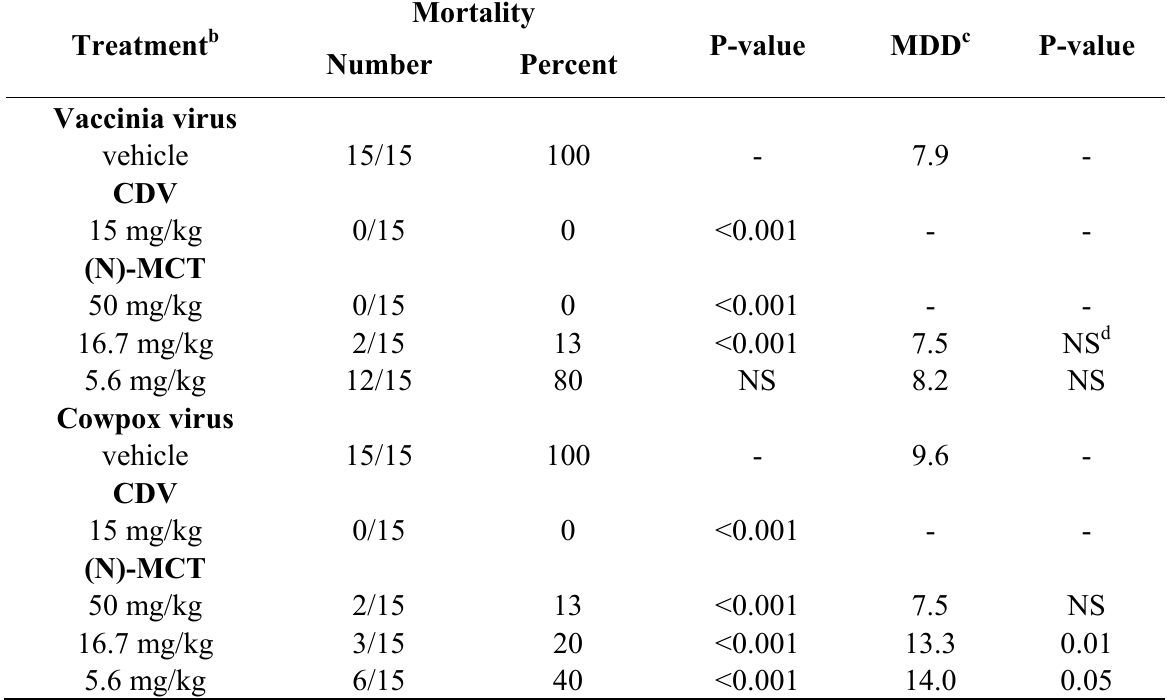
Table 2. Efficacy of (N)-MCT in BALB/c mice infected intranasally with vaccinia or cowpox virus a